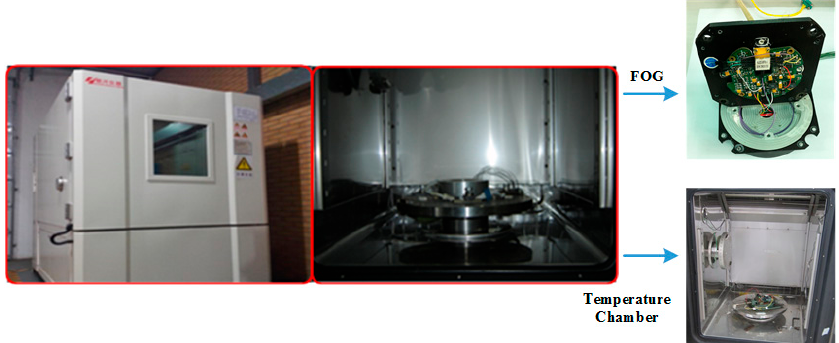
Figure 4. Experimental equipment arrangement of fiber optic gyroscope (FOG).